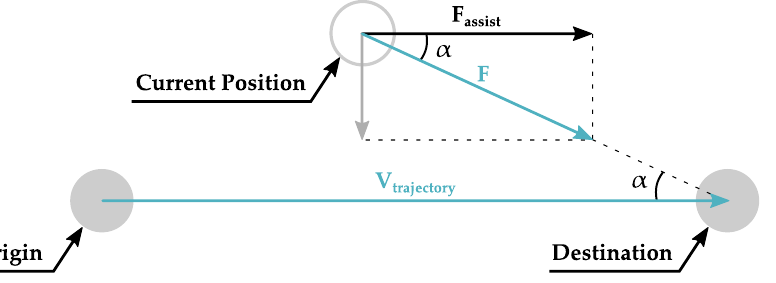
Figure 7. Diagram of assistance force vector calculation, F assist . V trajectory corresponds to the vector defined by the origin and destination of the trajectory towards the current target and F is the current force that the Rubidium is applying to the patient.